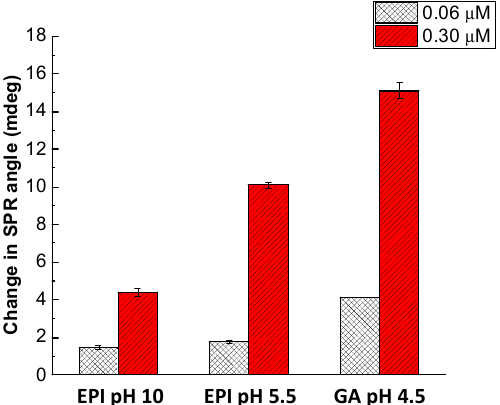
Figure 7. Glyphosate sorption onto CS/ZnO SPR sensor cross-linked for two glyphosate concentrations (0.06 and 0.30 μ M), at pH 5.5. Experimental conditions: cross-linking for 2 h with GA (2.5%, pH 4.5), EPI (0.1 mM, pH 10) at 40 °C or EPI (0.1 mM, pH 5.5) at 40 °C followed by washing with UPW.